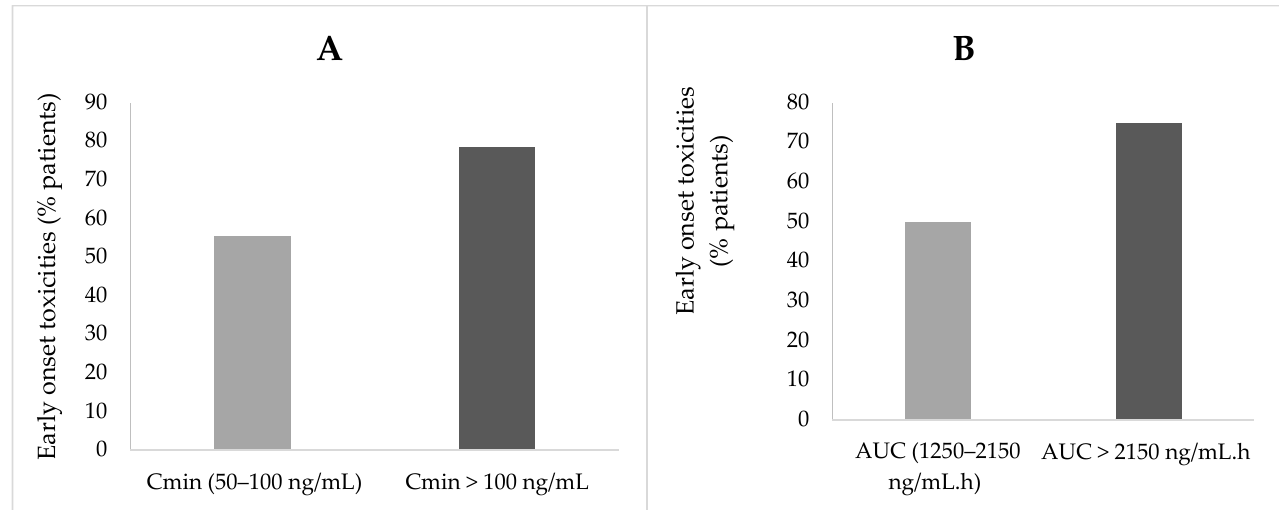
Figure 3 . ( A , B ) Evaluation of early-onset toxicities ( ≥ Grade 2) as a function of trough level concentrations (Cmin) (A) and exposure (AUC) (B) .